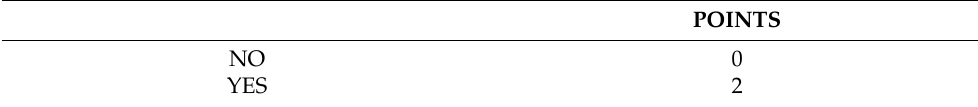
Table A6. Oral anticoagulation.